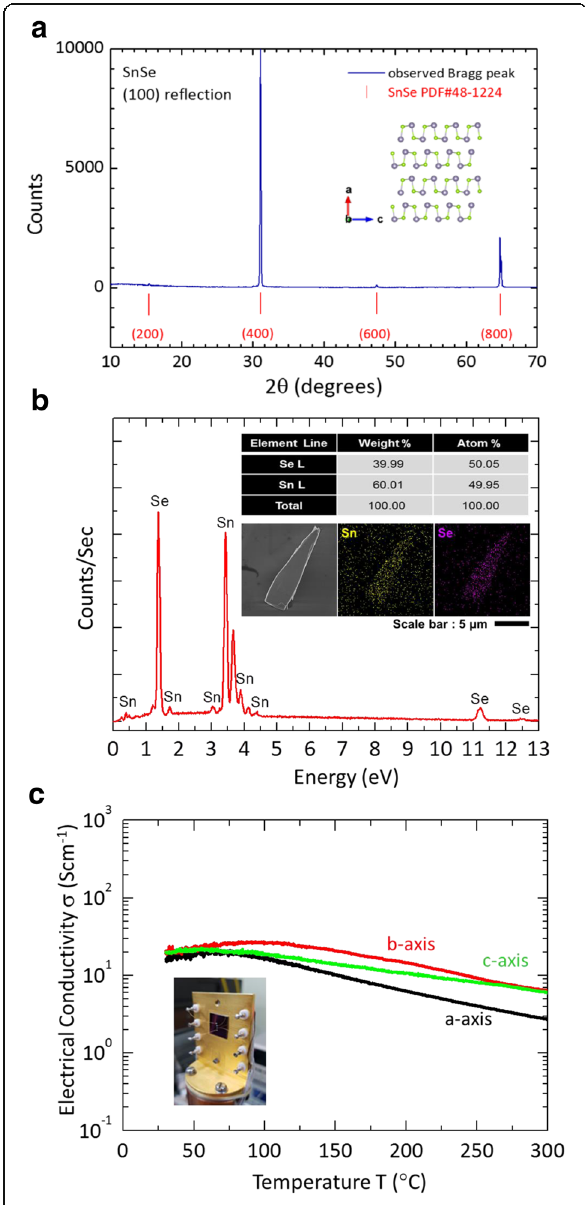
Fig. 2 a XRD pattern of SnSe single crystals, showing a clear (h00) diffraction. b EDX spectrum of the SnSe single crystals . Inset shows the detailed information of atomic ratio of Sn and Se. Insets exhibit a SEM image and EDX mapping of a SnSe nanoflake FET with a device thickness of 90 nm. c Temperature-dependent electrical conductivity of the SnSe single crystals, for temperatures ranging from 30 – 300 K, measured using the four-point-probe